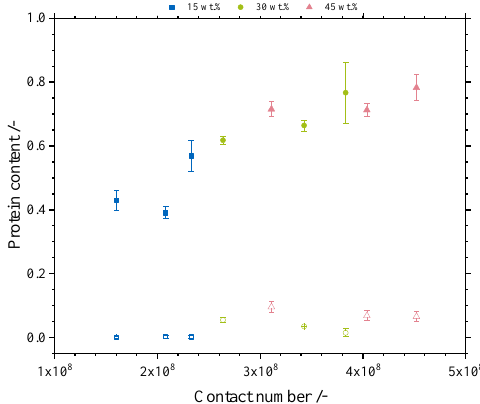
Figure 6. Protein content of separated powders on the cathode (closed symbols) and on the anode (open symbols). To improve clarity, the average protein content is plotted for all plain wall measurements. An increase in contact number results in a significant increase in protein content on the cathode. The protein content on the anode increases slightly with the increase in contact